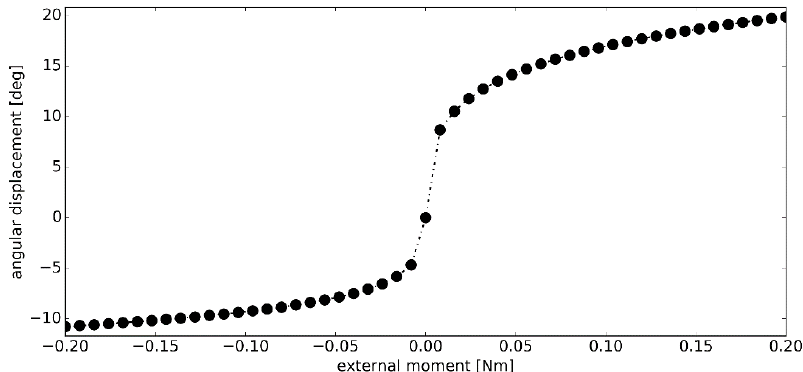
Figure 4. The angular displacement ∆ θ versus the external moment M ext in simulation #1.